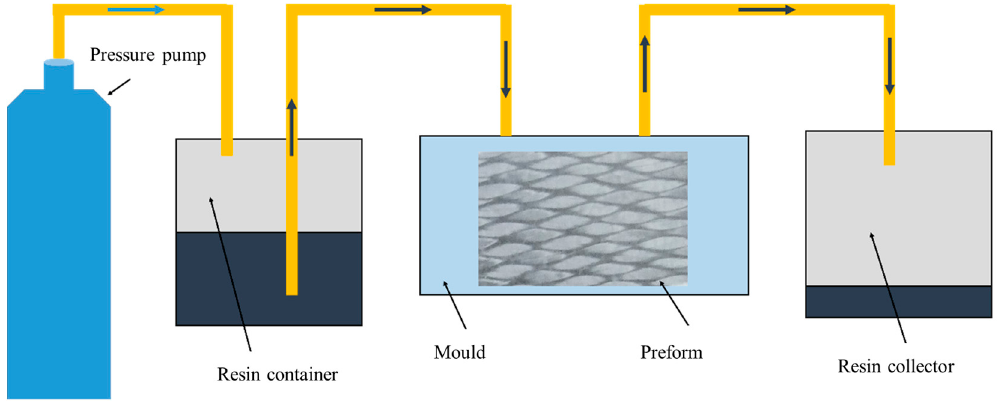
Figure 4. Diagram of the RTM process. Table 1. Mechanical properties of T700-12K carbon fiber and TDE86 resin.